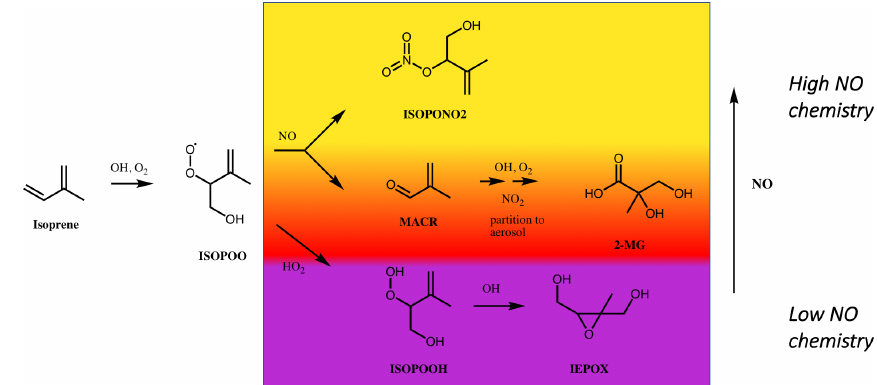
Figure 1. Formation pathways of isoprene oxidation products used as tracers of high- and low-NO chemistry in this work. Following reaction of the primary VOC, isoprene, with OH, a peroxy radical intermediate (ISOPOO) is formed. At low NO concentrations, ISOPOO reacts with HO 2 (or other RO 2 ), to yield hydroperoxide (ISOPOOH) isomers ((4,3)-ISOPOOH isomer is shown), which can be rapidly oxidised to isoprene epoxydiol (IEPOX) isomers. At high NO concentrations, ISOPOO reacts with NO, a minor product of which is an isoprene nitrate (ISOPONO2). One of the major products of the ISOPOO reaction with NO is methacrolein (MACR), the subsequent oxidation of which, in the presence of NO 2 , can lead to 2-methylglyceric acid (2-MGA) and its corresponding oligomers and organosulfates in the aerosol phase. Measurements of these products in the gas or aerosol phase can be used as tracers for the chemical environment in which they were